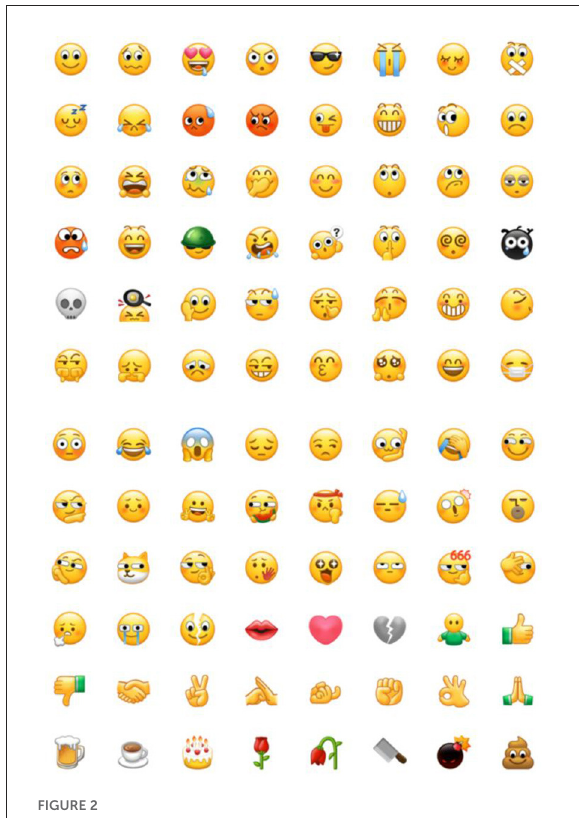
FIGURE2 The Emoji in education